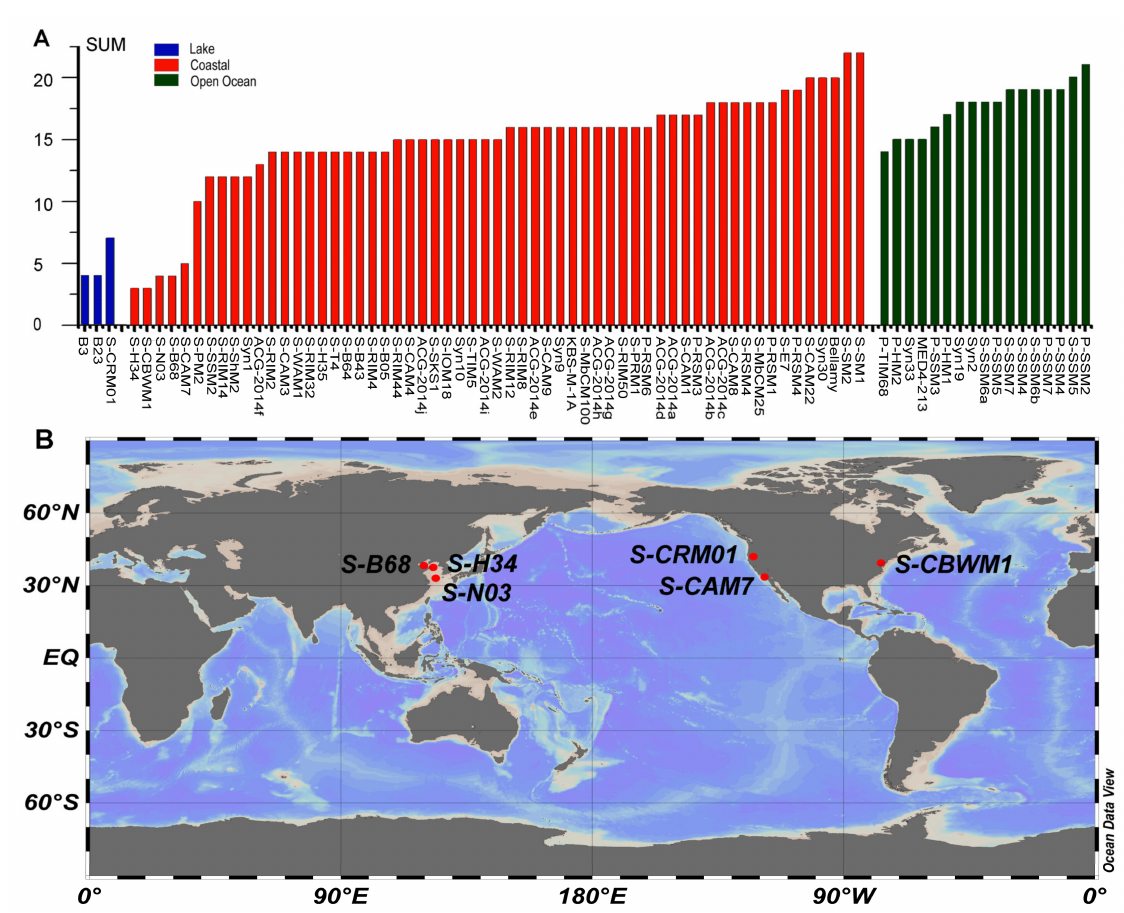
Figure 4. ( A ) A histogram showing the distribution of AMG content in 81 cyanomyoviruses from di ff erent type of habitat (coastal areas, open oceans and lakes). ( B ) The isolation sites of the published cyanophages with AMGs content less than 10.